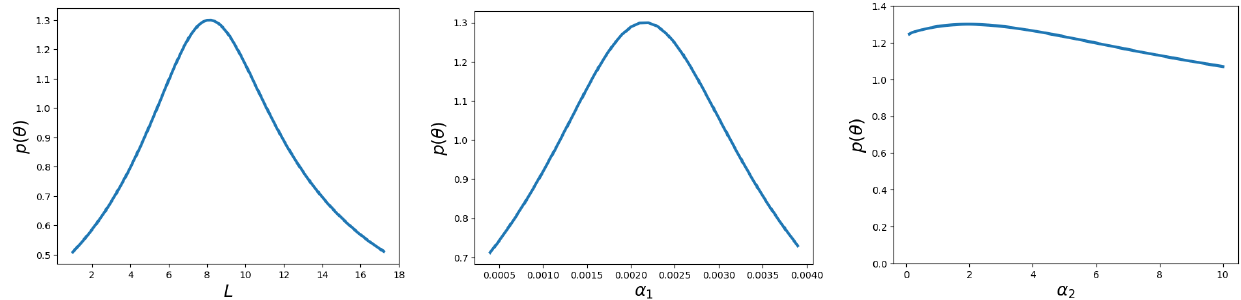
Figure 3. Profiles of p ( θ ) for individual parameters providing surrogates for the profile likelihood for parameters L , α 1 , α 2